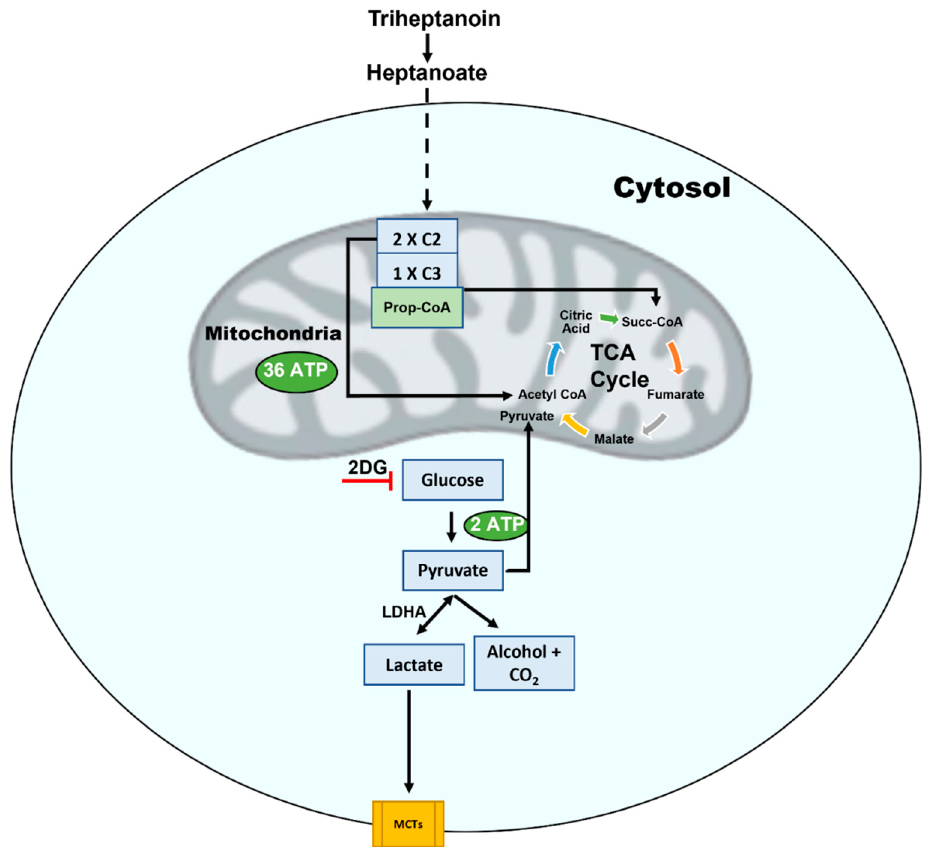
Figure 6. Triheptanoin, triglyceride of heptanoate replenishes the tricarboxylic acid (TCA) cycle